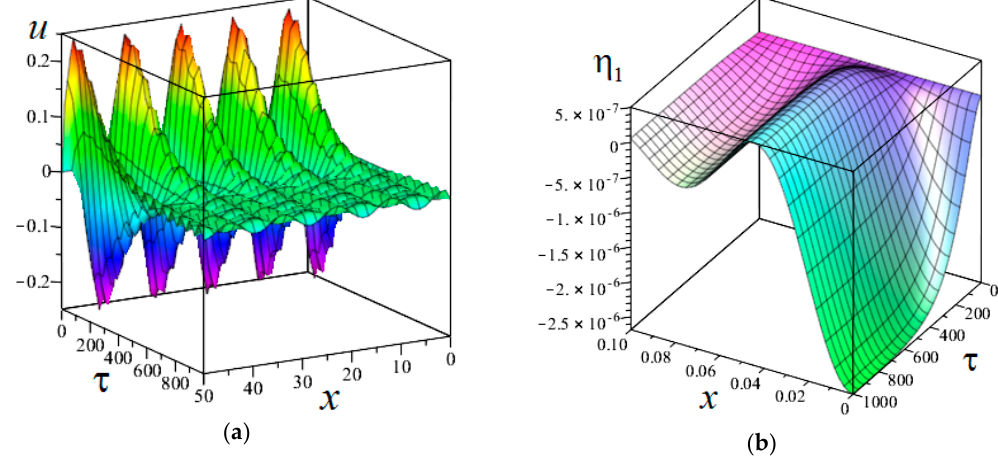
Figure 5. ( a ) Displacement u ; and ( b ) concentration increment η 1